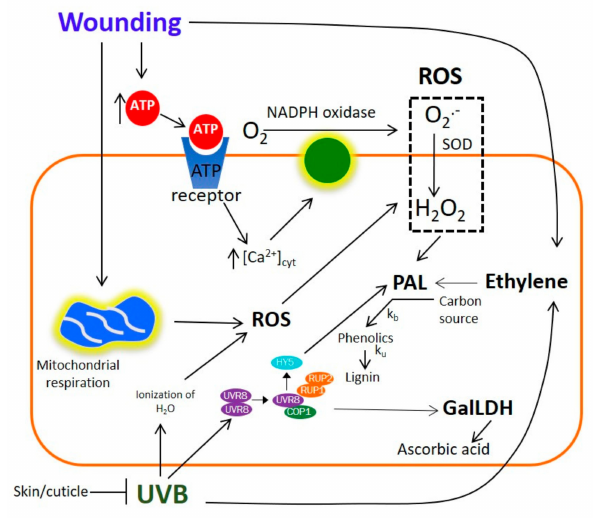
Figure 6. Proposed model explaining the combined effect of wounding and UVB radiation stresses on the accumulation of phenolic compounds and ascorbic acid in prickly